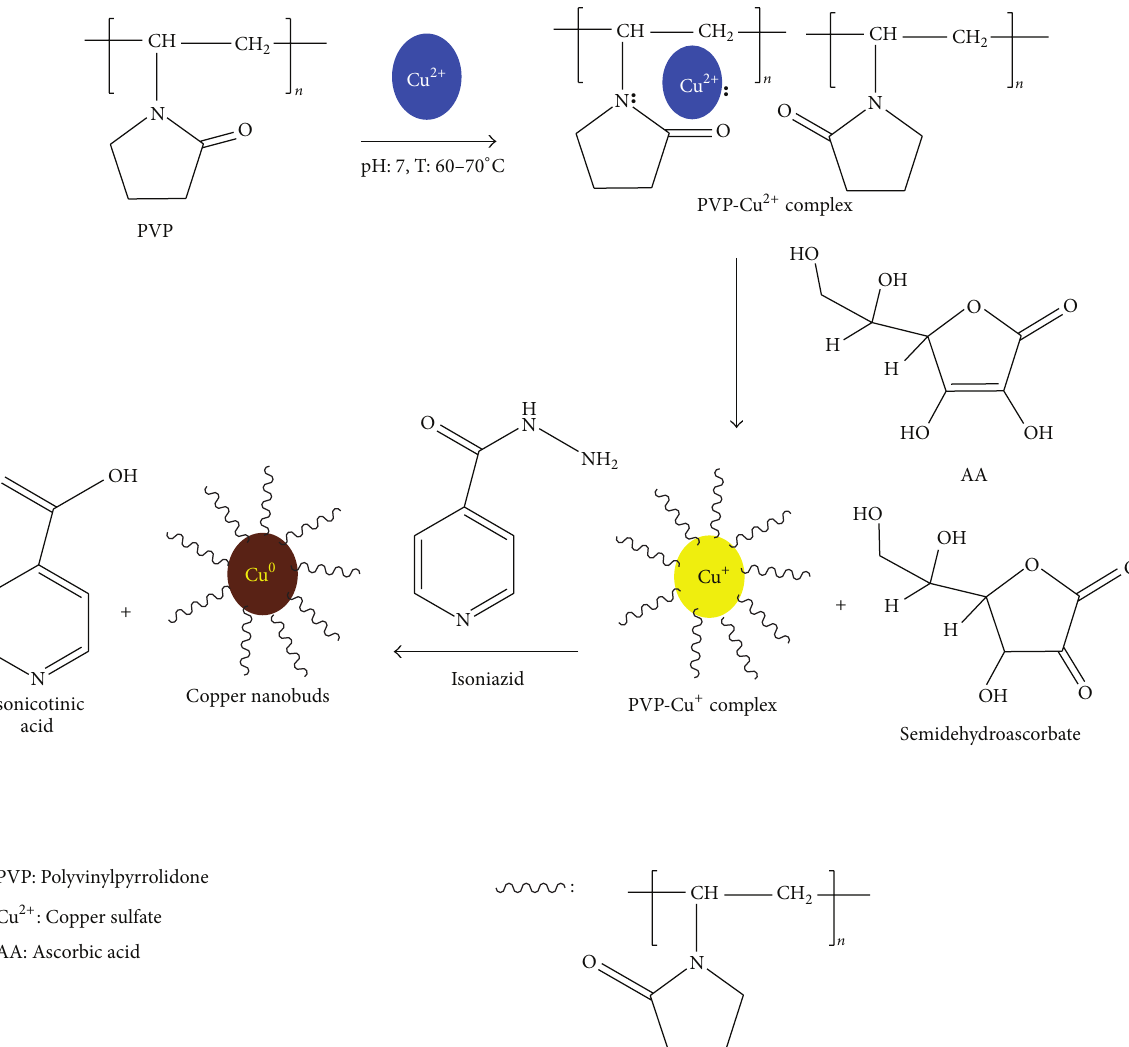
Scheme 2: Mechanism of the formation of copper nanobuds. Copper sulfate forms a complex with PVP when the solution is maintained at pH-7 (60–70 ∘ C). The solution turns yellow after the addition of ascorbic acid indicating the formation of Cu(I). INH was added dropwise to this reaction mixture resulting in jasmine bud-shaped copper